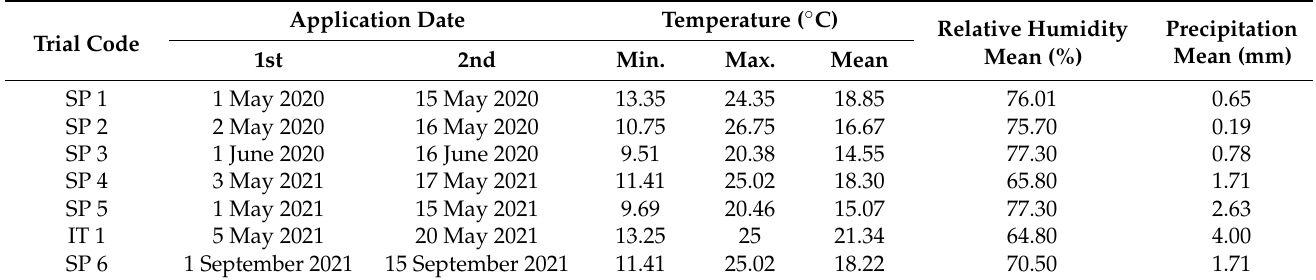
Table 3. Trial conditions in each field trial. All trials lasted 30 days.